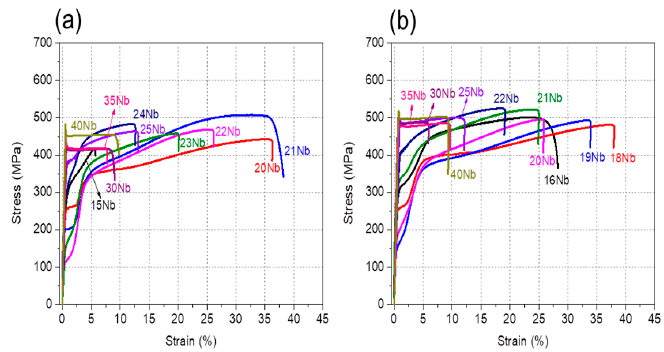
Figure 4. Stress-strain curves of Ti–Nb–Zr alloys obtained at room temperature: ( a ) Ti–Nb–4Zr alloys; ( b ) Ti–Nb–8Zr alloys.